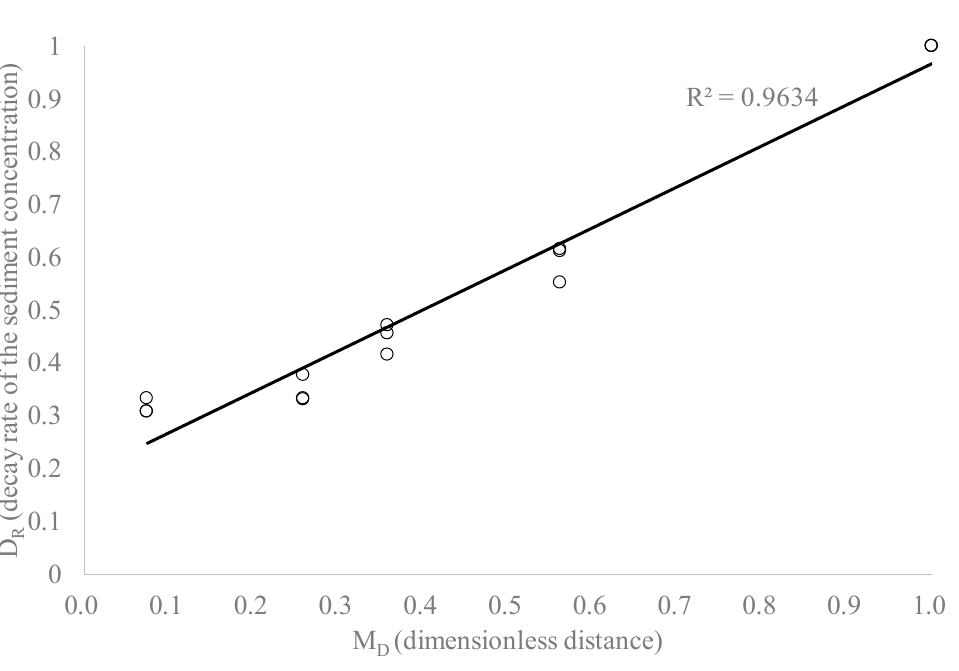
Figure 10. Relationship of D R and M D.